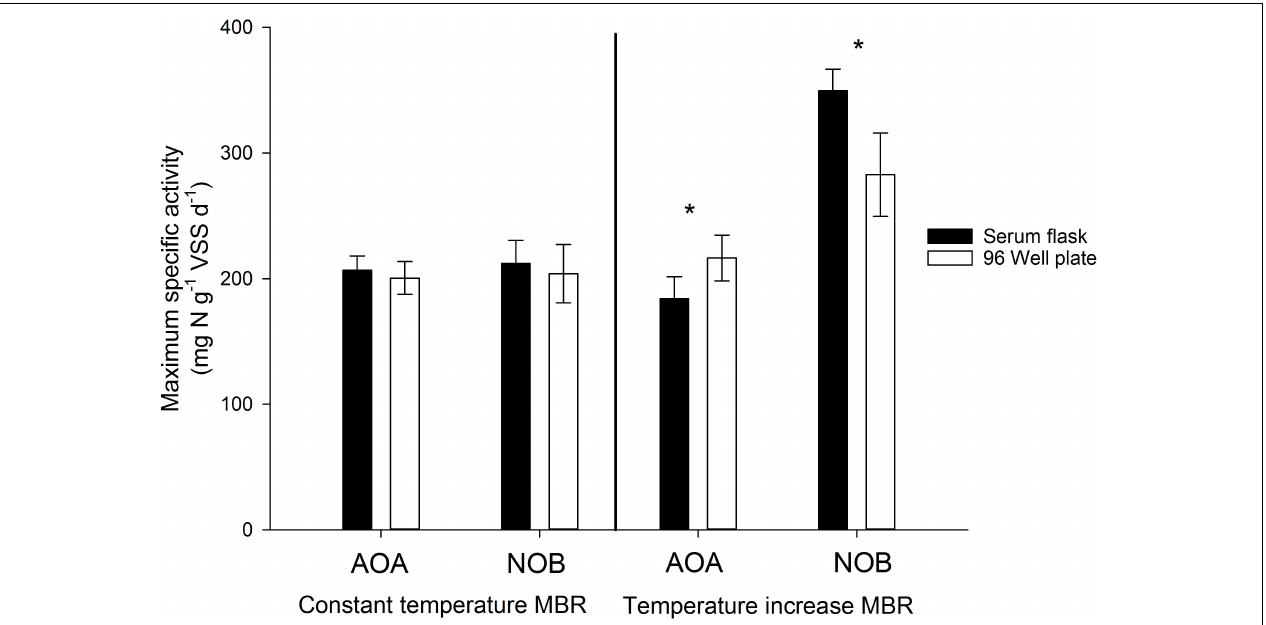
FIGURE 6 | Maximum specific activity of AOA and NOB during the ex-situ activity measurements in serum flasks vs. 96 Well plate using thermophilic nitrifying biomass from the constant temperature MBR and the temperature increase MBR (Courtens et al., 2016a,b). Error bars represent the standard deviation of triplicate and sextuple incubations of the same inoculum in serum flasks and 96 Well plates respectively (technical replicates). Significant differences between serum flask and 96 Well plate values are indicated with an